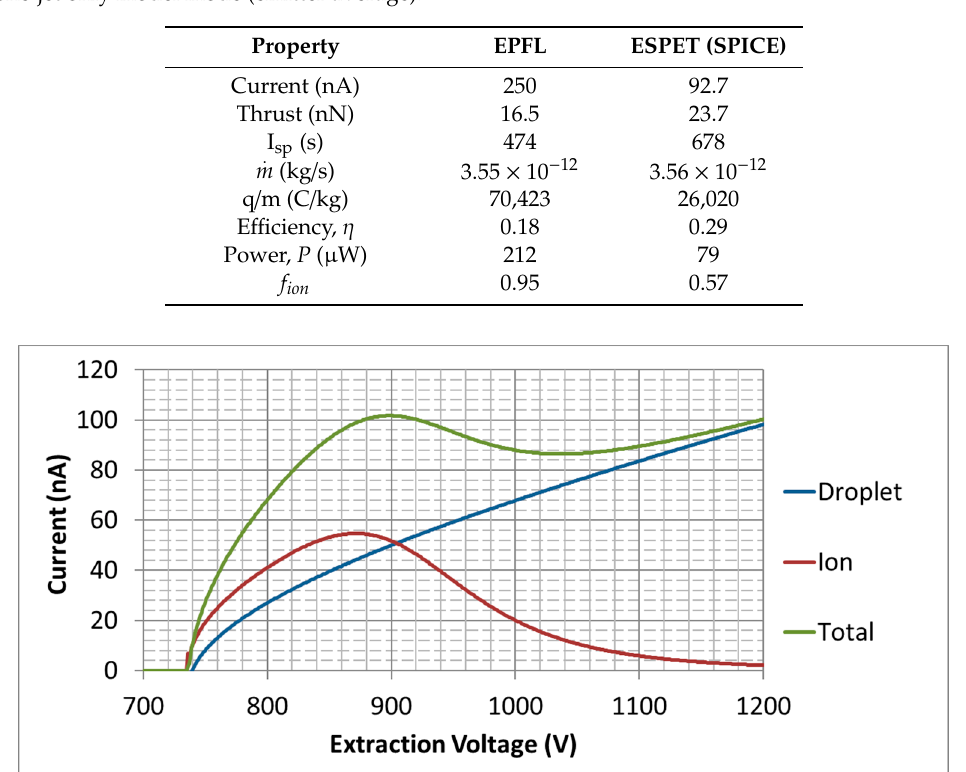
Figure 13. VI curves for ions and droplets computed for the circuit shown in Figure 12.